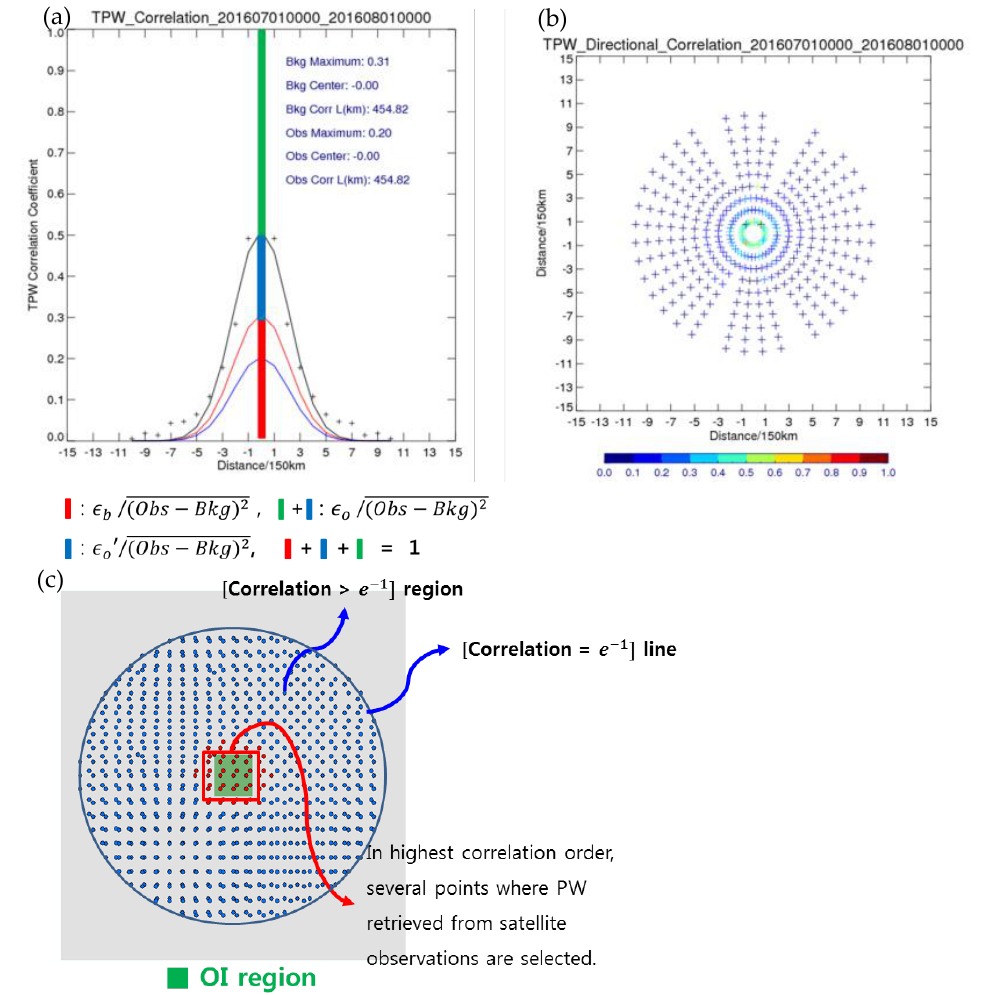
Figure 3. ( a ) Estimation of the correlation length scale and error covariances using the new approach in the scale of the correlation coefficient (July 2016 daily average); ( b ) isotropic assumption (July 2016 monthly average); and ( c ) optimal interpolation (OI) region selection. ( a , b ) are the NOAA-18,19 TPW product case.